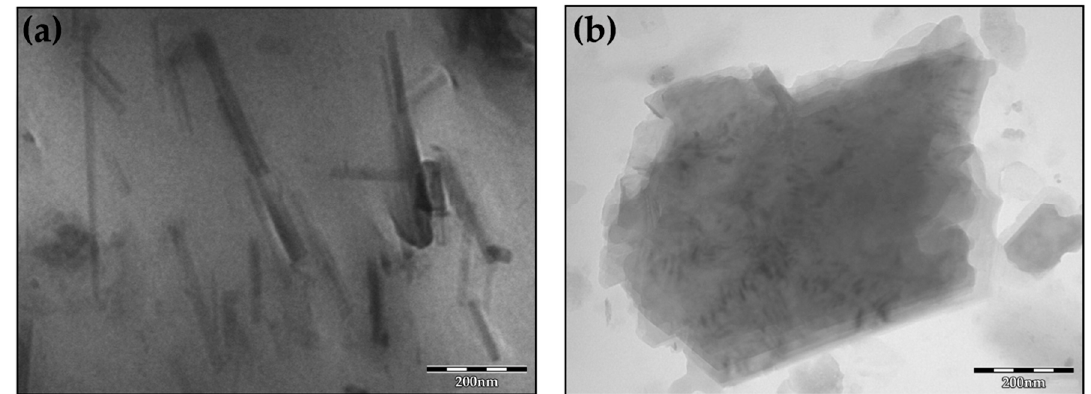
Figure 5. Transmission electron microscopy (TEM) micrographs of ( a ) PLA/Paly-VTMS (7 wt%) and ( b ) PLA/Paly-APTES (7 wt%) nanocomposites.